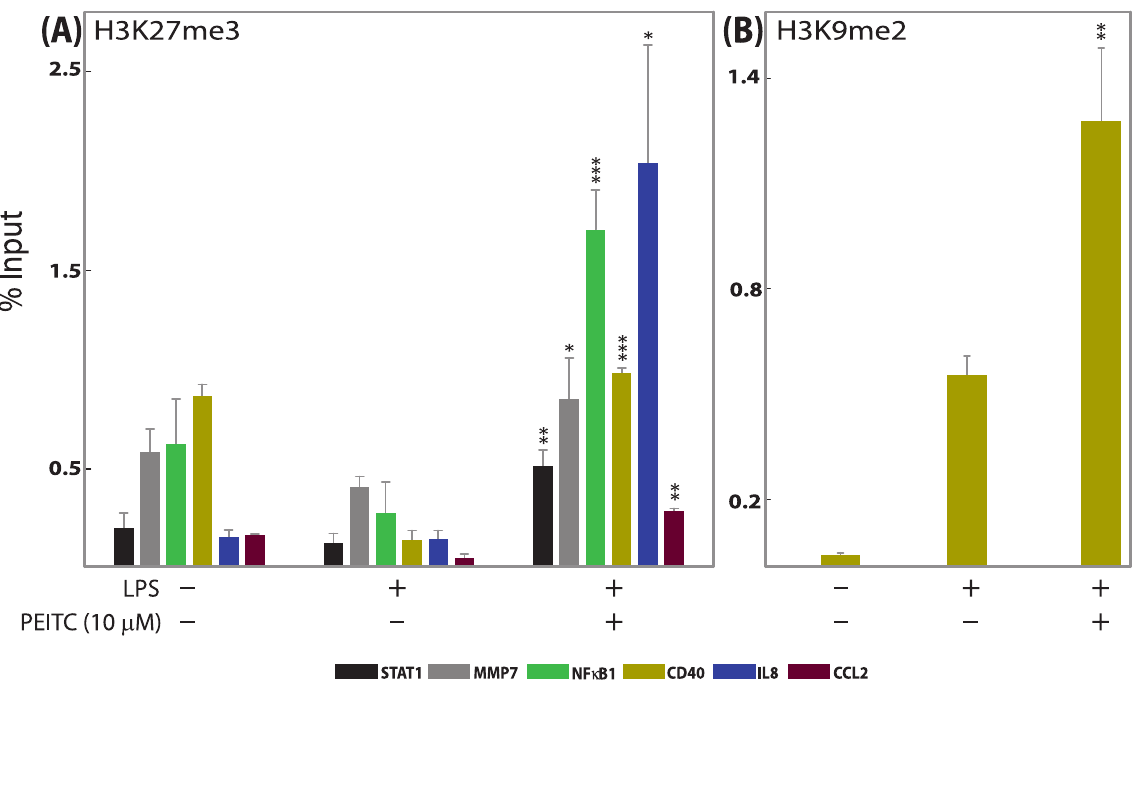
Figure 3. Histone H3 methylation changes at the promoter regions of genes of interest (GoI) in SW480 cells. Chromatin from SW480 cells was harvested after 5 h of 10- m M PEITC treatment. The results of ChIP analyses using (A) anti-trimethyl-Histone H3 Lys27 (H3K27me3) and (B) anti-dimethyl-Histone H3 Lys9 (H3K9me2) antibodies are shown. Out of 13 GoIs tested in SW480 cells, six genes showed statistically significant PEITC- associated changes in H3K27me3 states and one gene showed statistically significant PEITC-associated changes in H3K9me2 state. DNA sequences were quantified by real-time PCR using promoter primers. Average percentage input 6 SEM (n=3) from each experiment is plotted. *p , 0.05, **p , 0.01, ***p , 0.001 compared with positive-control cells.